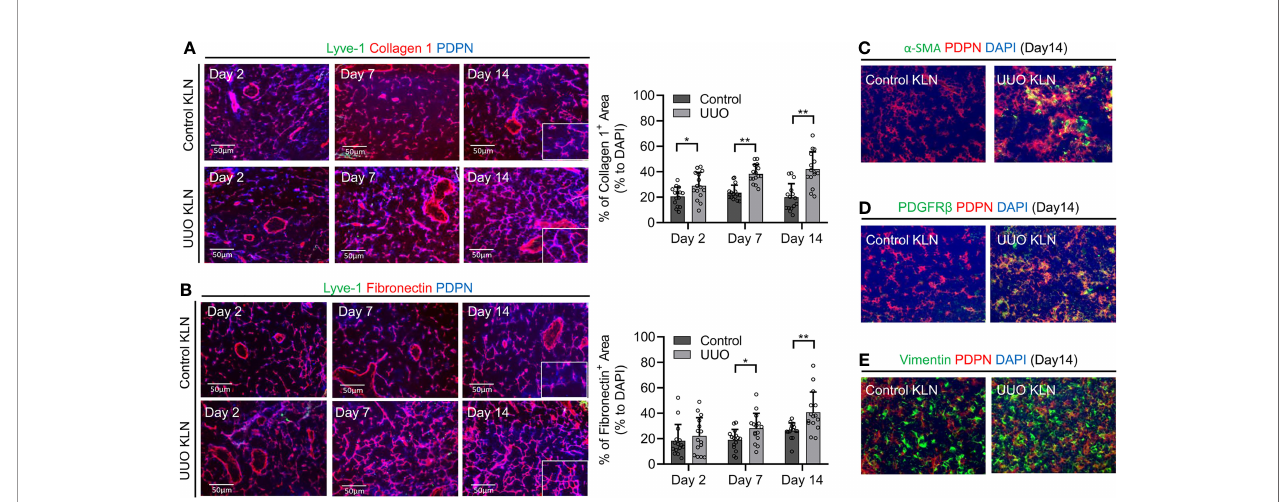
FIGURE 1 | Contribution of FRCs to increase in ECM density in the KLN over time. (A) Fluorescence micrographs of Lyve-1 + lymphatic vessels (green), collagen 1 fi bers (red), and PDPN + cells (blue) demonstrate increased density of collagen I fi bers and colocalization with Lyve-1 - PDPN + FRCs through Day 14. Semiquantitative analysis and comparison of collagen I + -stained area between the UUO and contralateral (control) KLNs show signi fi cantly higher density of collagen 1 + fi bers normalized to DAPI-positive area in the UUO KLN at all time points (n=15 random fi elds of sections from 3 mice). (B) Fluorescence micrographs of Lyve-1 - PDPN + FRCs (blue) and fi bronectin fi bers (red) show increased density of fi bronectin fi bers and colocalization with FRCs through Day 14. Semi-quantitative analysis and comparison of fi bronectin + -stained area shows signi fi cantly higher density of fi bronectin fi bers at Days 7 and 14 in UUO KLN as compared to contralateral (control) KLN (n=15 random microscopic fi elds of sections from 3 mice). (C – E) Fluorescence micrographs of UUO KLN and contralateral (control) KLN sections at Day 14 demonstrate increased expression of (C) a -SMA (green), (D) PDGFR b (green), and (E) vimentin (green), and increased colocalization (yellow) with PDPN + FRCs (red) in UUO KLN at Day 14 (DAPI nuclear stain, blue). Data represented by means ± SEM. *p < 0.05, **p <